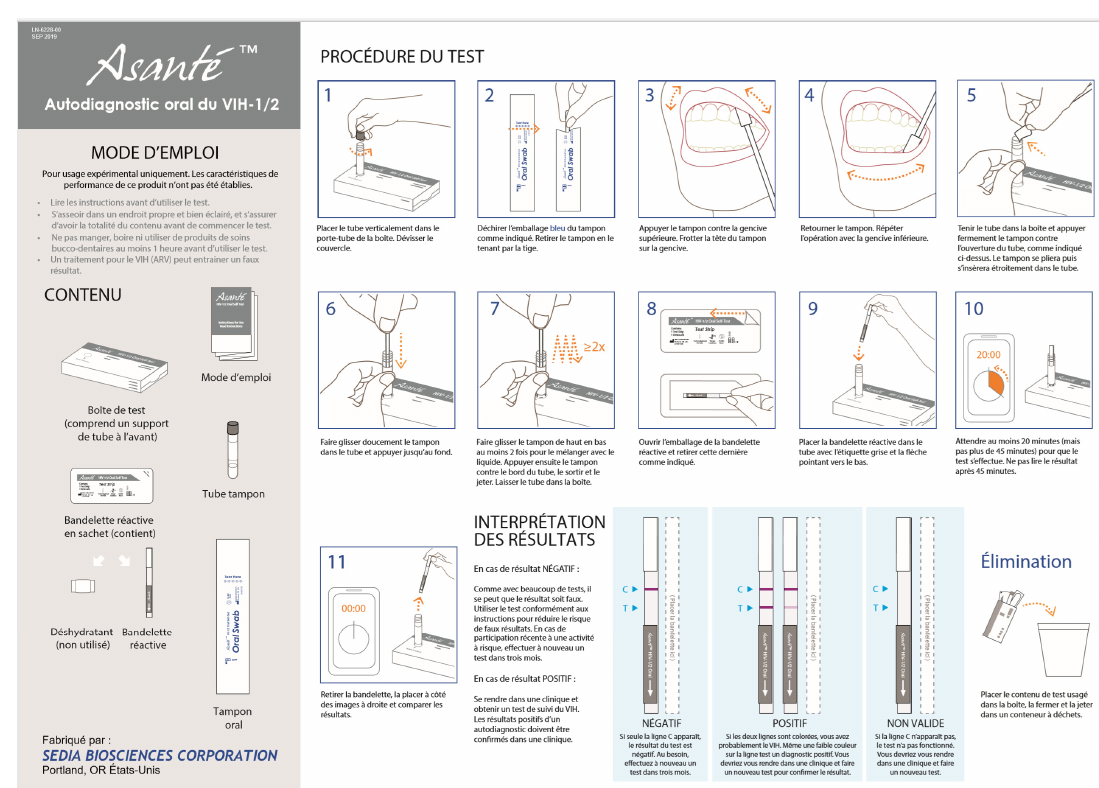
Figure A1. Asante™ HIV-1/2 Oral self-test used in South Africa.